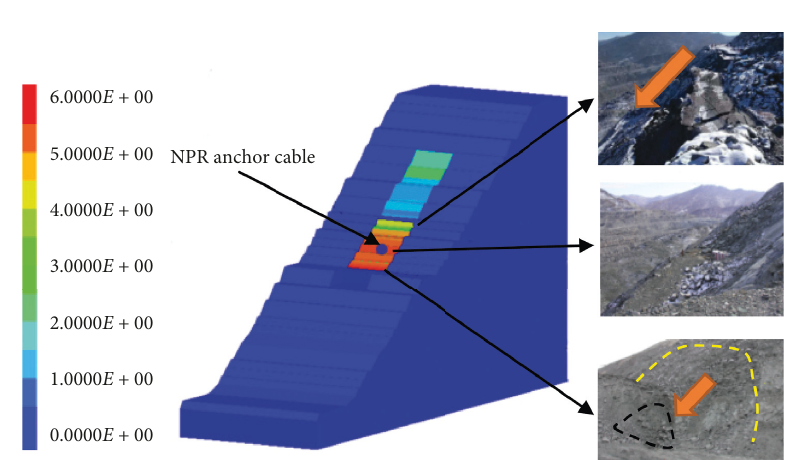
Figure 29: Comparison of simulation results with field conditions.